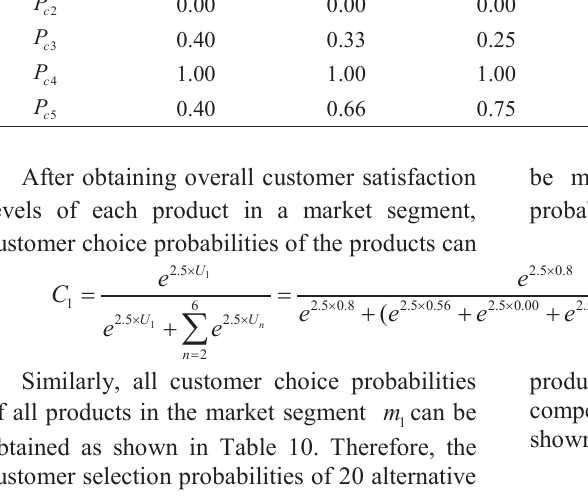
Table 10. customer choice probabilities of all products in the market segment